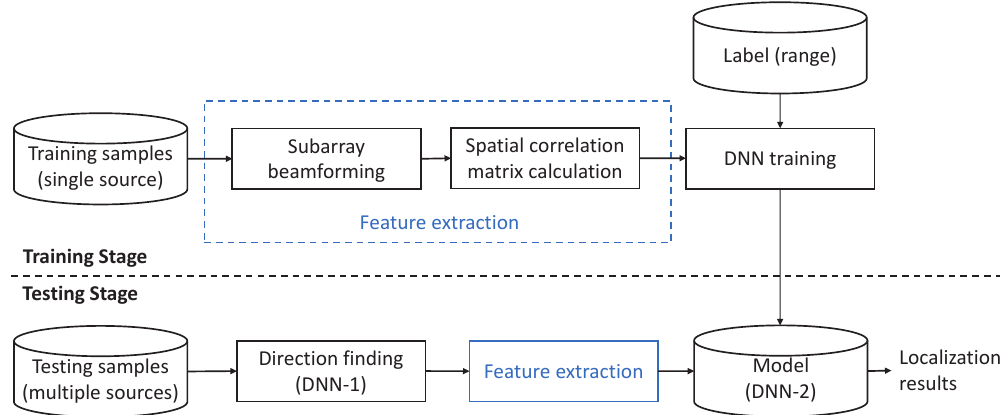
Figure 2. Block diagram of the proposed